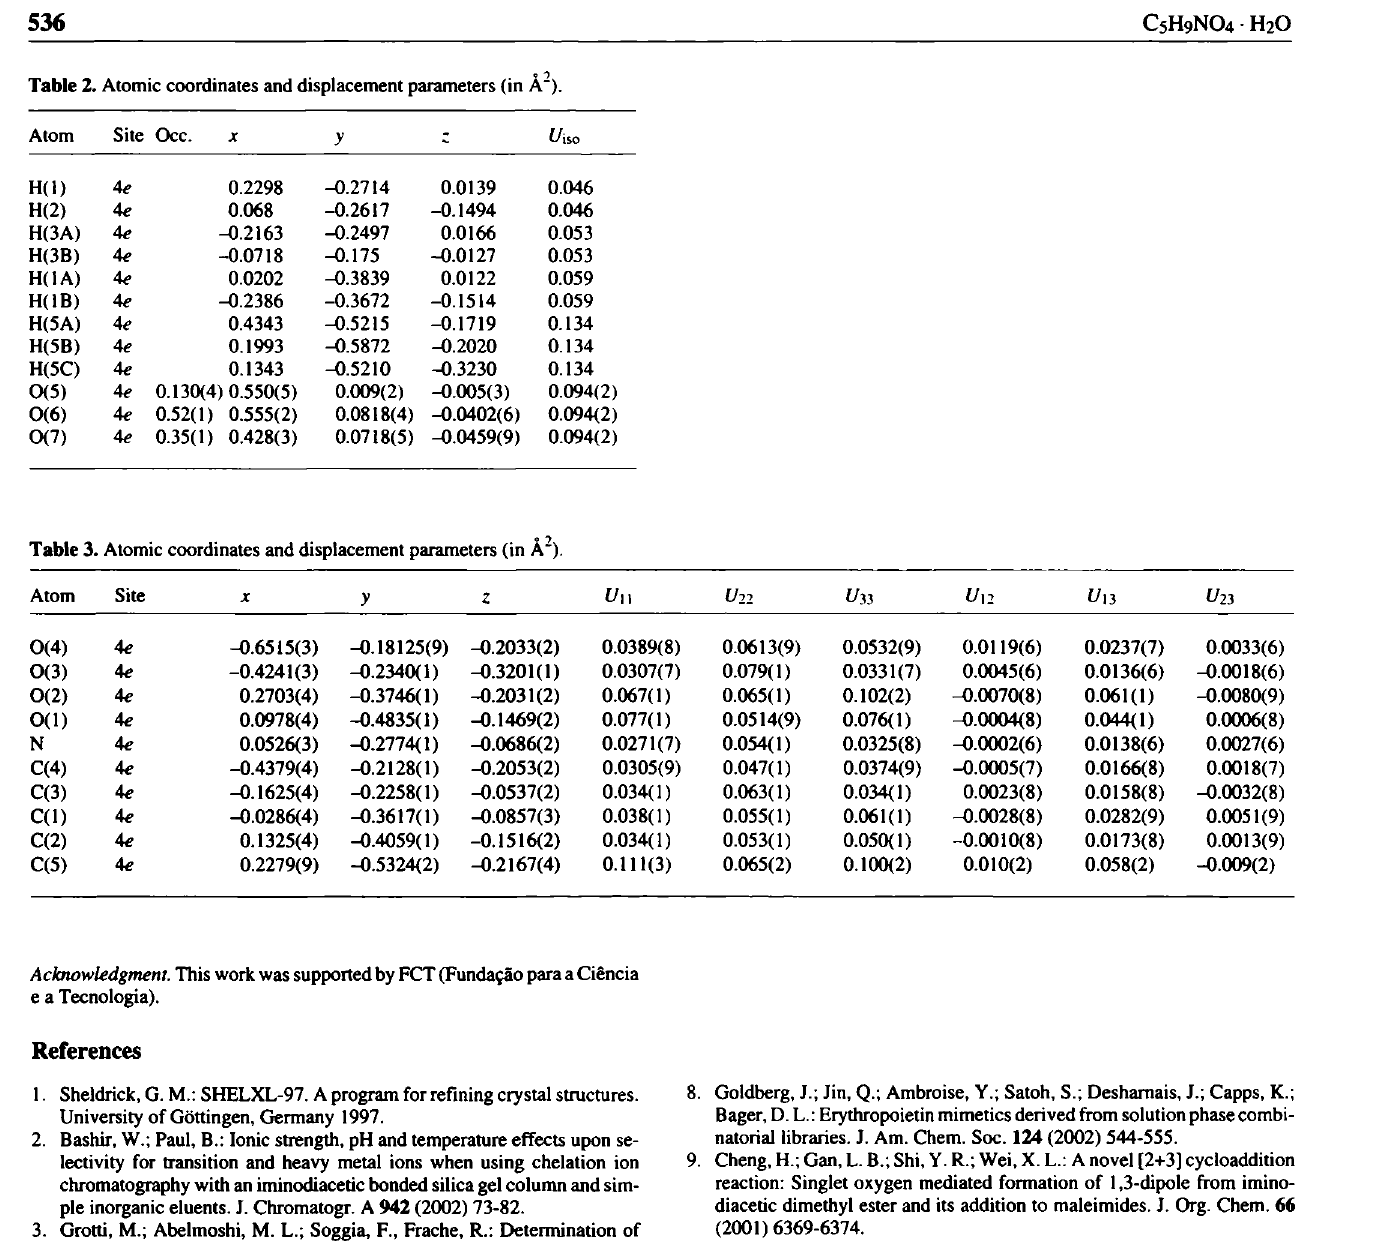
Table 2. Atomic coordinates and displacement parameters (in Ä 2 ).